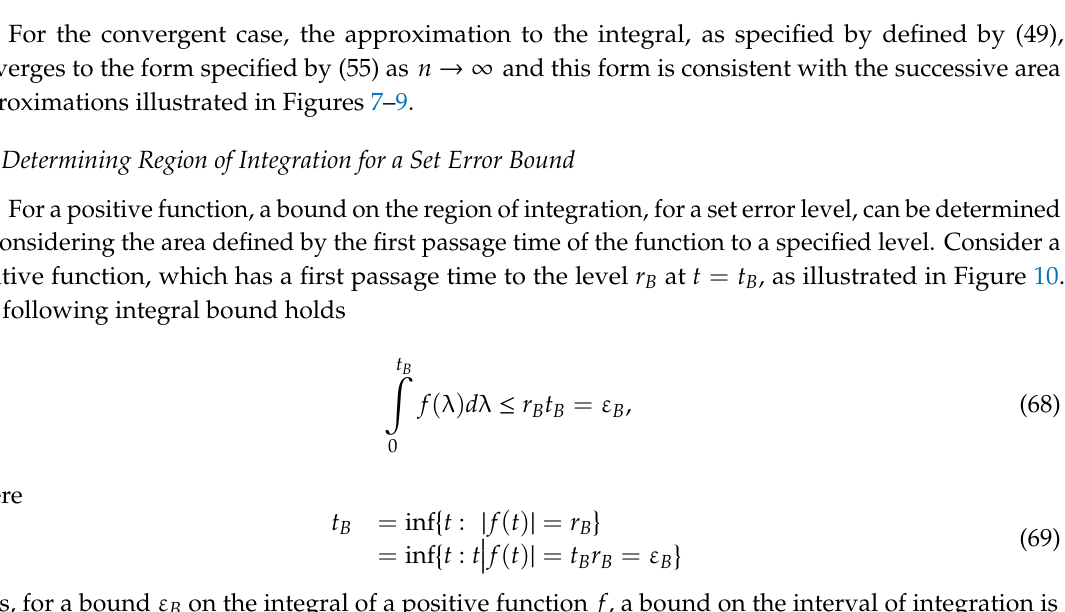
Figure 9. Illustration of the areas defined by a quadratic approximation to the residual function r 2 and based on f ( 2 ) ( α ) and f ( 2 ) ( t ) .